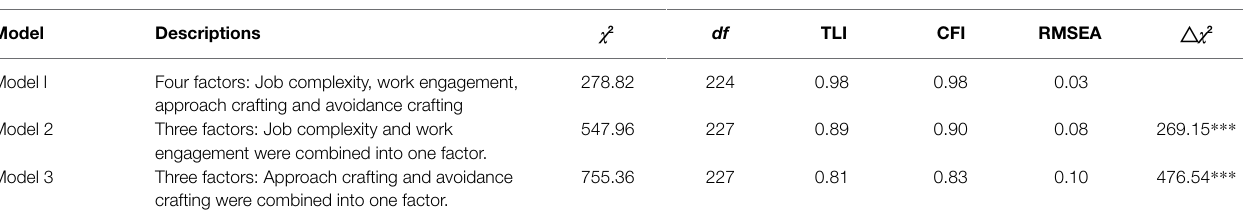
TABLE 3 | The confirmatory factor analysis